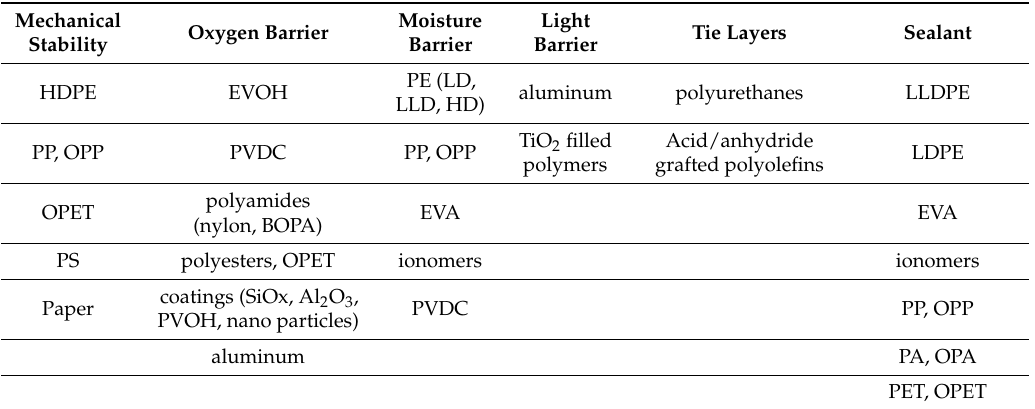
Table 1. Overview of common functional layers [3,14,18]. Abbreviations used: BOPA (biaxially oriented polyamide), EVA (polyethylene-vinyl acetate), OPA (oriented polyamide), OPET (oriented polyethylene terephthalate), OPP (oriented polypropene), PVDC (polyvinylidene chloride), PVOH